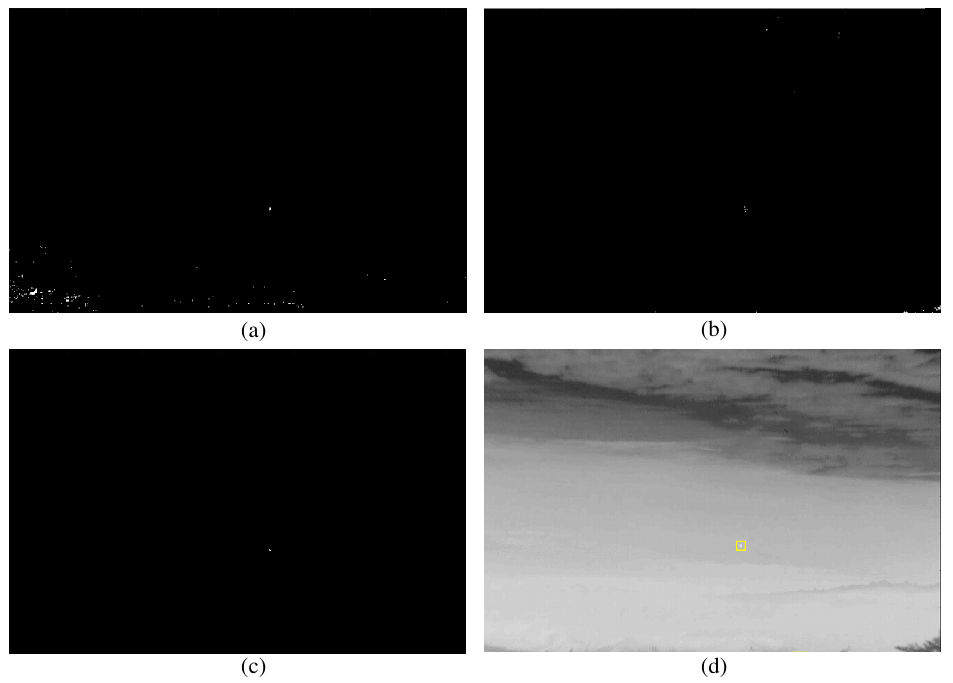
Figure 4. Successful small infrared target detection results: ( a ) fused intensity map; ( b ) fused orientation map; ( c ) enhanced map; ( d ) final